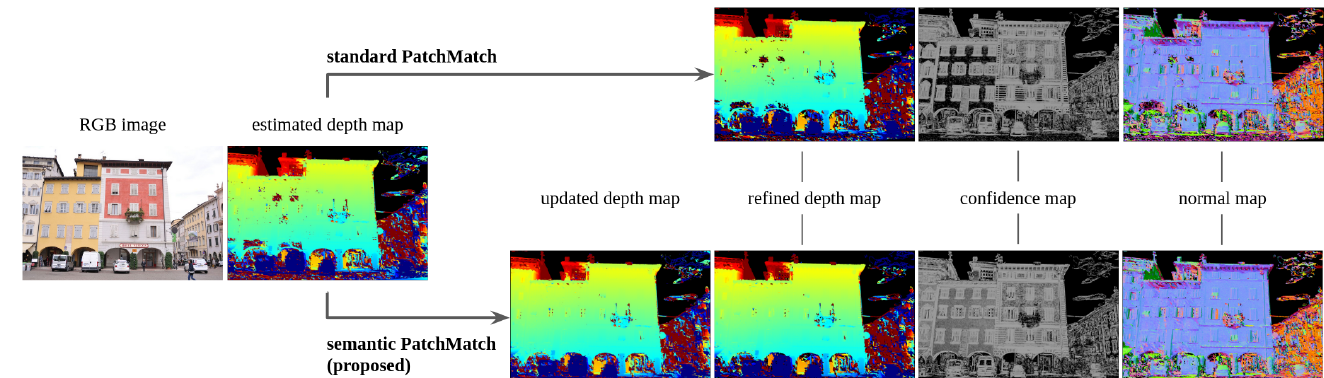
Figure 2. The standard PatchMatch pipeline [9] vs. the proposed method. From left to right: the input image and the respective estimated depth map after standard PatchMatch iterations. In the upper part, the standard approach outputs filtered depth maps (gap interpolation and small segment removal) as well as confidence and normal maps. In the proposed approach (lower part), extra semantic iterations are added after the geometric prior estimation. Resulting depth maps contain less gaps, normal maps are smoother and confidence is higher (scale black to white, with white representing higher